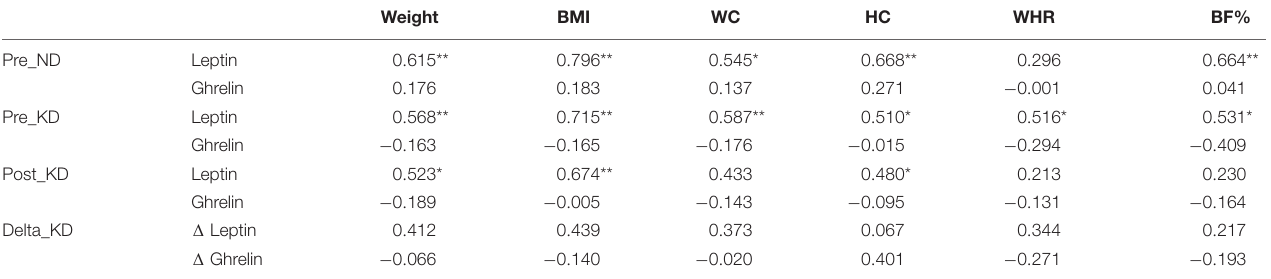
TABLE 3 | The correlation coefficients between the hormones and body composition. Weight